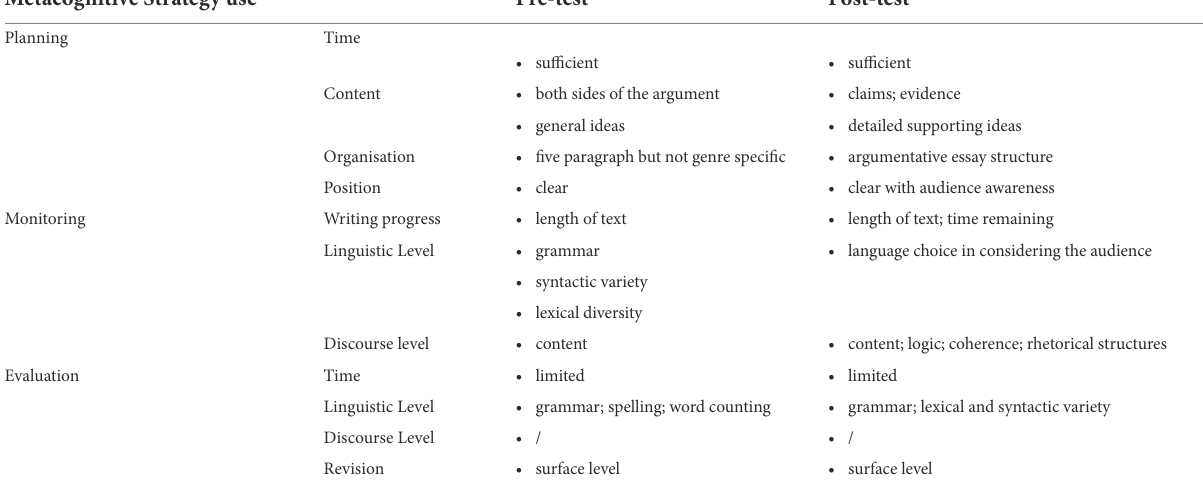
TABLE 5 Chengji’s metacognitive strategy development